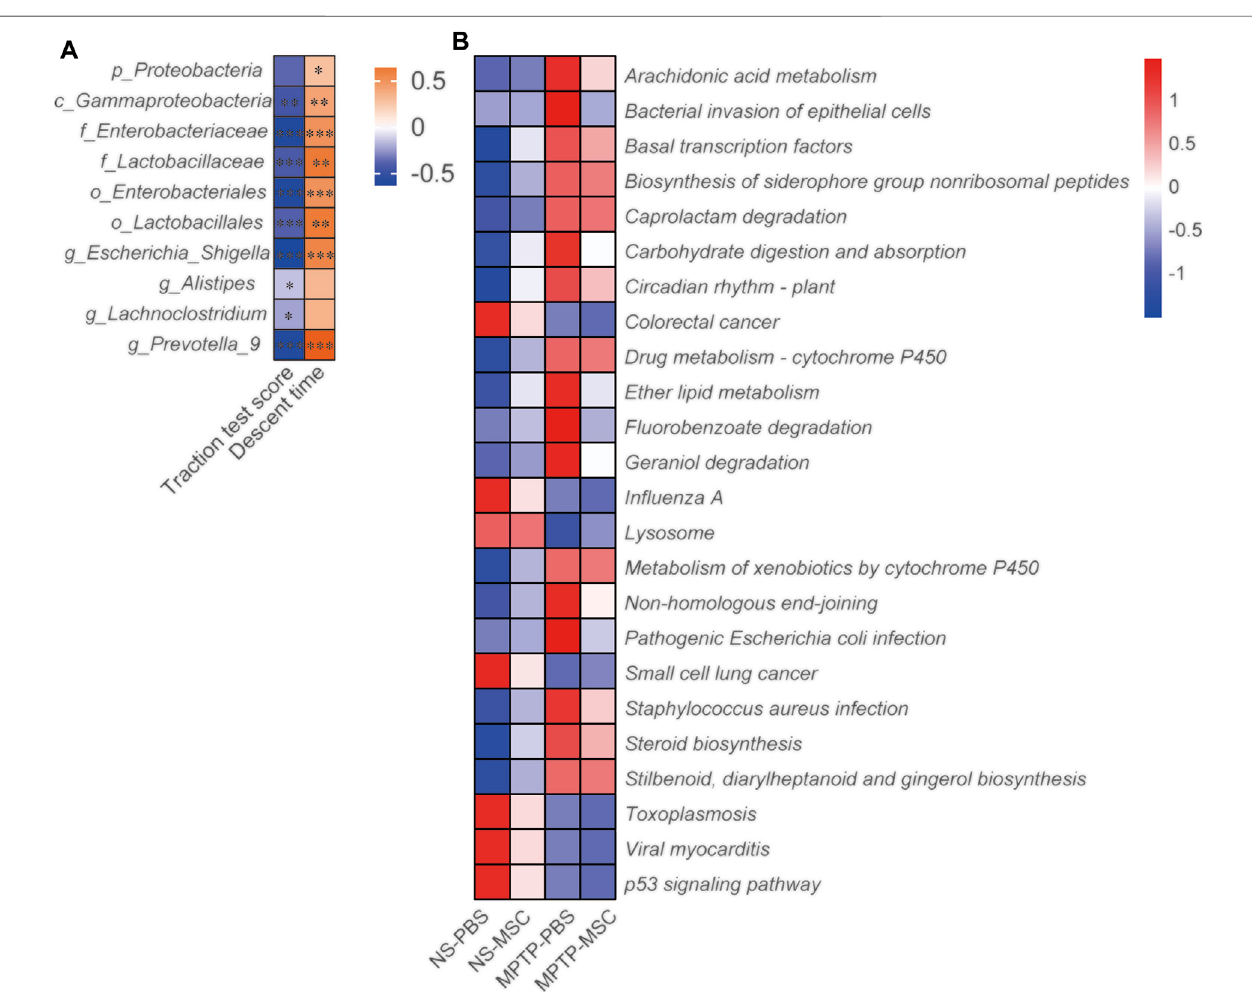
FIGURE 5 | UC-MSCs regulated the effects of gut microbiota in MPTP-induced PD mice. (A) The motor function score and relative abundance of gut microbiota were analyzed by Spearman correlation analyses. The association coef fi cient was performed on the legend of the heatmap. *, **, *** represent the correlation signi fi cant ( p < 0.05, p < 0.01, p < 0.001, respectively); (B) PICRUSt analyses between the four groups. n (cid:1) 12.